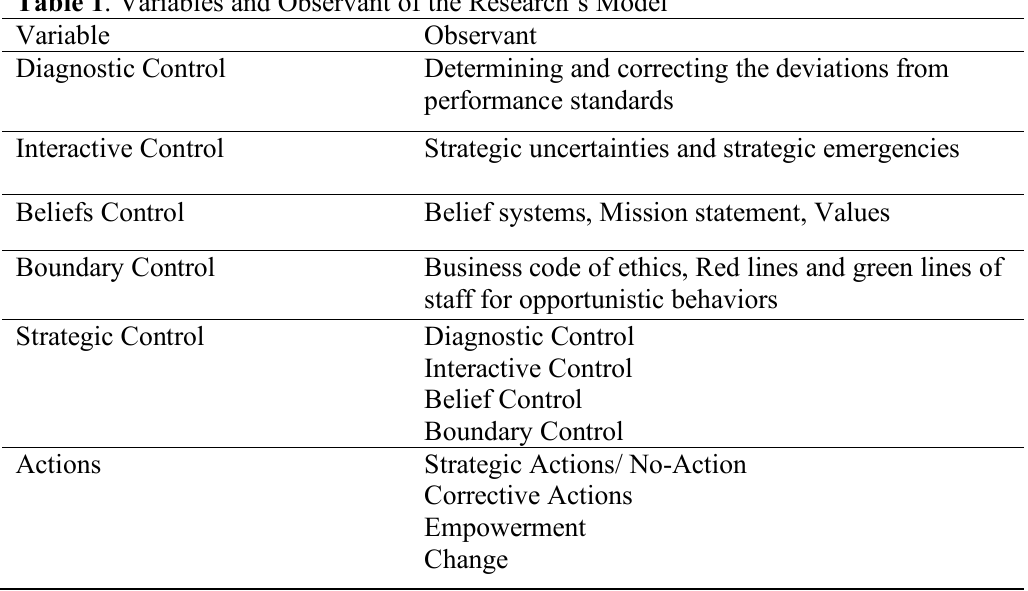
Table 1 . Variables and Observant of the Research’s Model